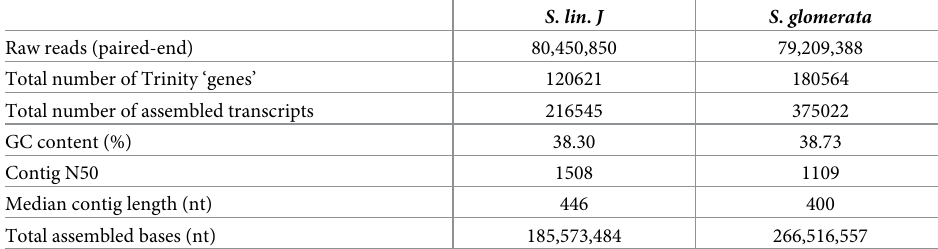
Table 1. Assembly statistics for S . lin . J and S . glomerata